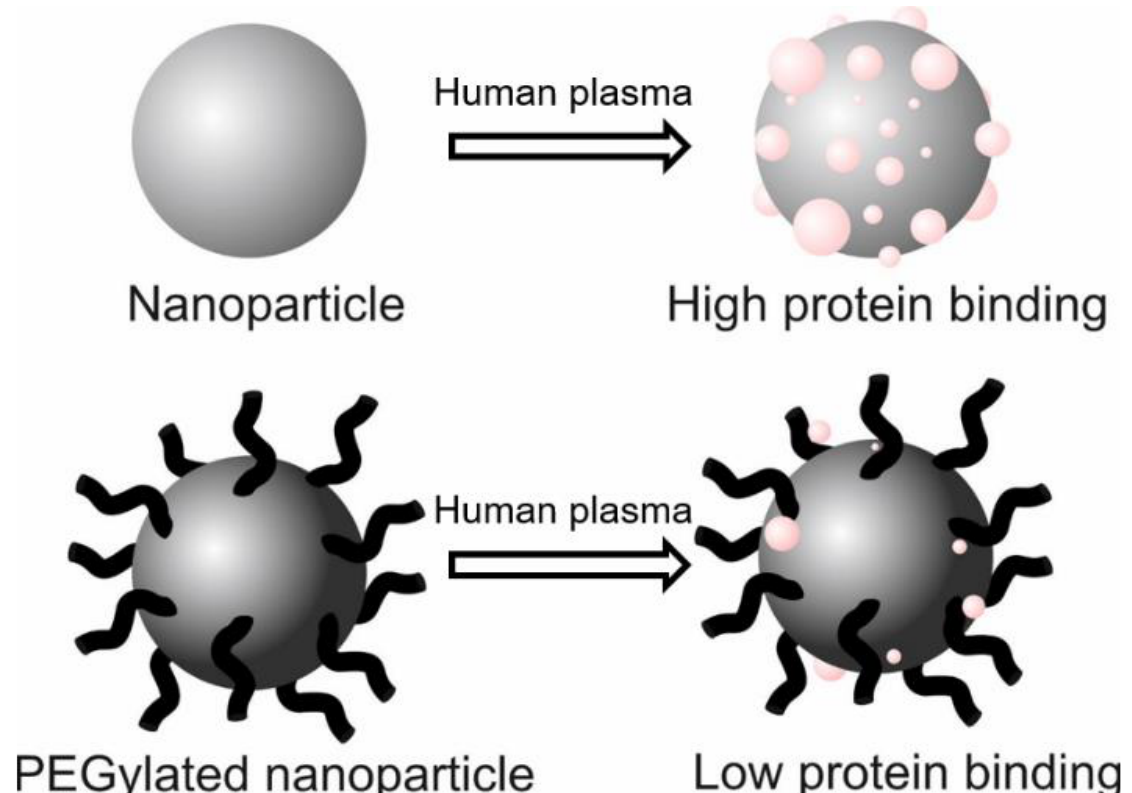
Figure 8. Schematic representation of the interaction of NPs with human plasma. PEGylated NPs are able to prevent the adsorption of proteins from the blood, increasing circulation time. Adapted from [208]. Copyright © 2022 Elsevier B.V. All rights reserved.